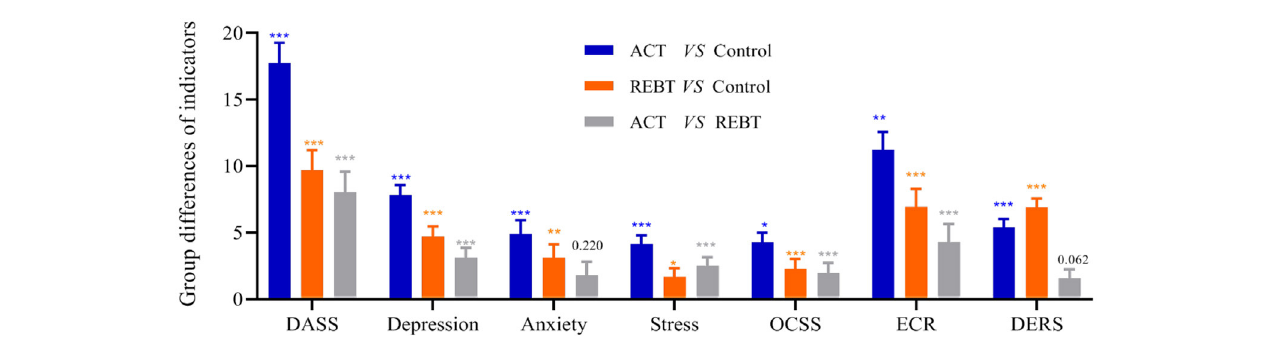
FIGURE3 The results of Bonferroni’s post hoc comparison (DASS, Depression, Anxiety, Stress, OCSS, ECR, and DERS). * p < 0.05; ** p < 0.01; *** p < 0.001; DASS, the scores of Depression Anxiety Stress Scale; Depression, the Depression subscale scores of DASS; Anxiety, the Anxiety subscale scores of DASS; Stress, the Stress subscale scores of DASS; OCSS, the scores of Obsessive-Compulsive Symptom Scale; ECR, the scores of Experiences in Close Relationships Inventory-Attachment Anxiety Subscale; DERS, the scores of Difficulties in Emotion Regulation Scale.